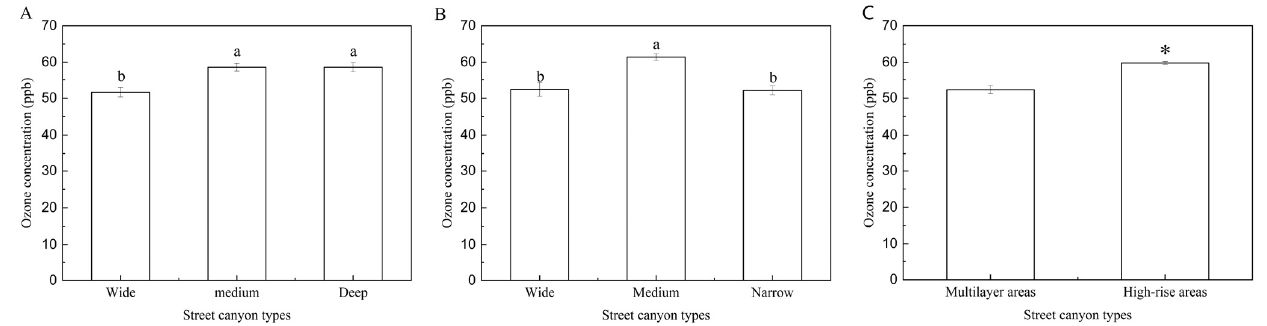
Figure 4. Ozone concentration (mean ± standard error) at 1.5 m varied among different types of street canyons divided by the AR ( A ), SVF ( B ), and building height ( C ). * and letters (a,b) represent the statistical difference between treatments. Different letters indicate significant difference in ozone concentration was found in different street canyon types.